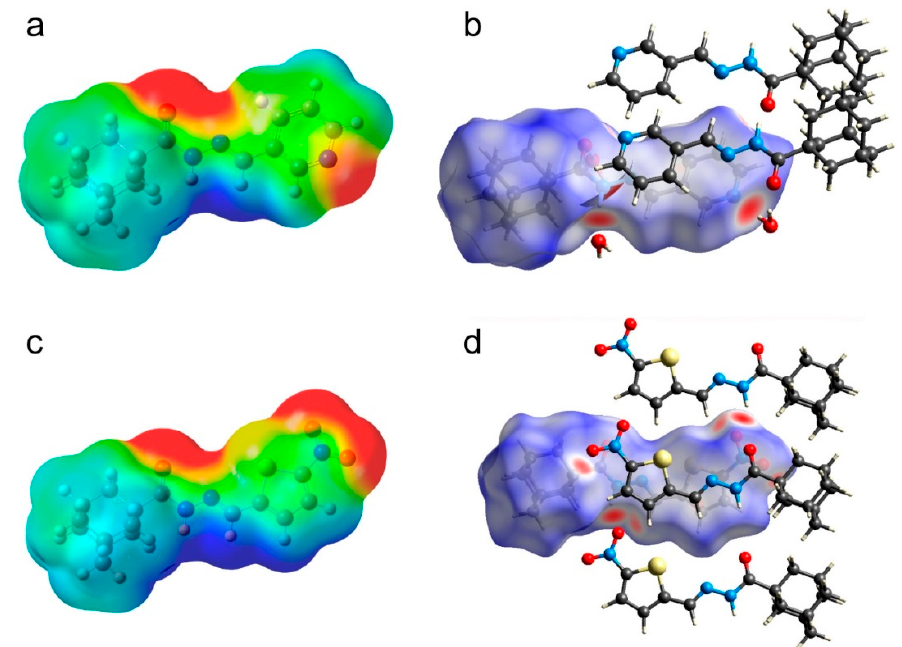
Figure 3. Isodensity (0.0004 e) and Hirshfeld surfaces for compounds 1 ( a and b ) and 2 ( c and d ). The electrostatic potential is mapped on the isodensity surfaces from red ( − 0.03 V) to blue (+0.03 V). Atom color code: C (grey), N (blue), O (red), H (white), S (yellow). The charge is asymmetrically distributed in the compounds.